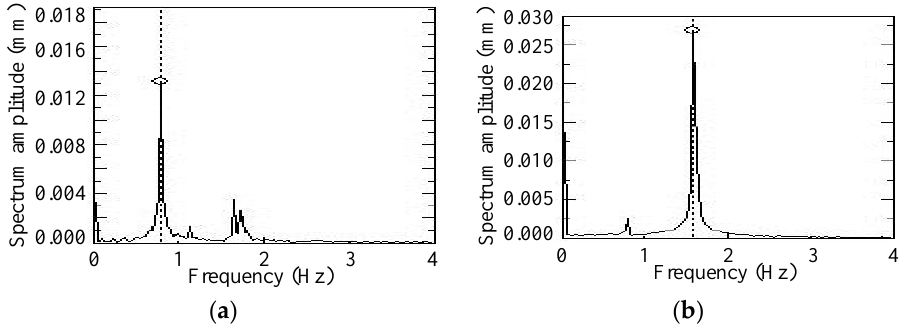
Figure 7. Frequency spectrum of the bridge structure: ( a ) transverse vibration; ( b ) vertical vibration.